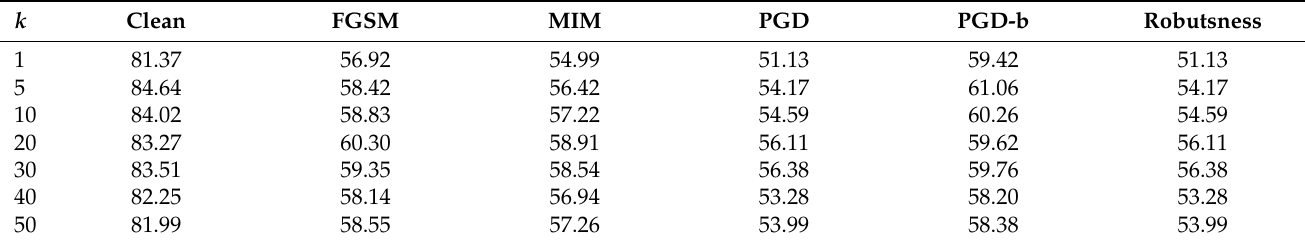
Table 2. Test accuracy of models training with different batch size radios.